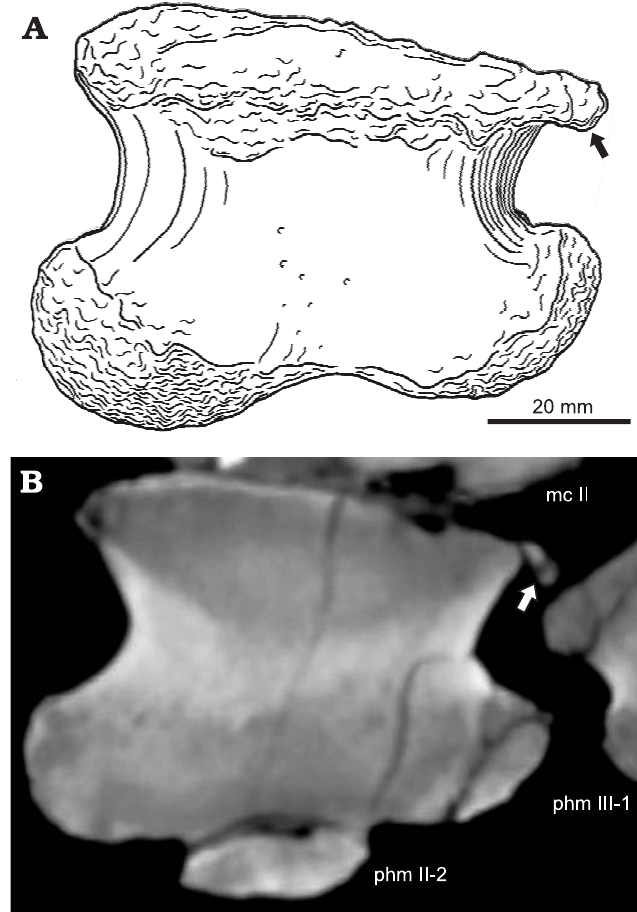
Fig. 6. Overgrowth type 2 exemplified in a drawing ( A , modified from Tschopp et al. 2015) and CT scan ( B ) of the left manual phalanx II-1 of the camarasaurid sauropod SMA 0002 from Upper Jurassic Morrison Formation, Howe-Stephens Quarry, Wyoming, USA. CT scan shows vari- able bone densities in the osteophyte, indicated by the different gray scales. Abbreviations: phm, phalanx of manual digit; mc,